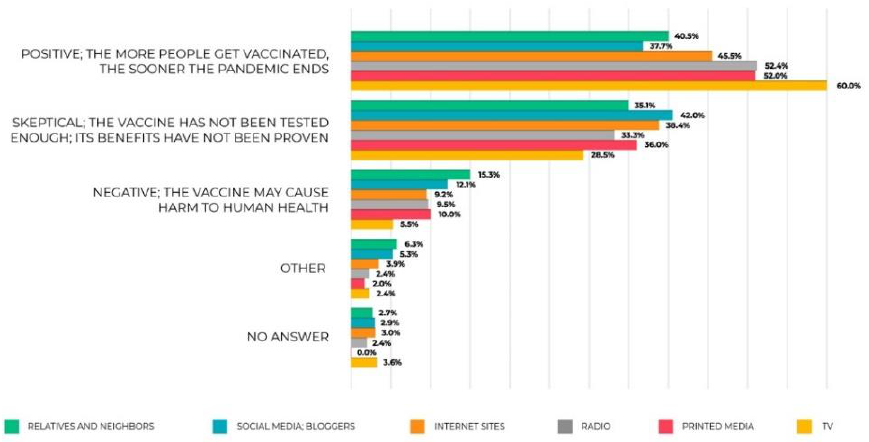
Figure 14. The respondents’ answers to the question: What is your attitude towards vaccination against COVID-19?